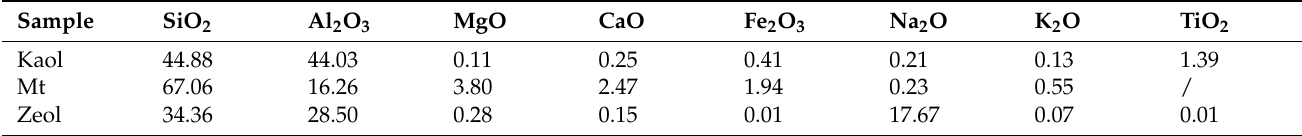
Table 1. Concentrations (%) of main compositions in the used Kaol, Mt, and